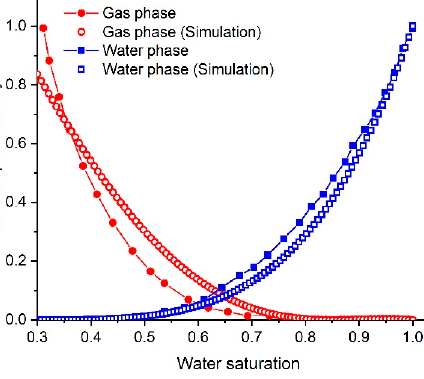
Figure 4. Relative permeability curve for history matching and simulation project. Table 1. Parameters of the numerical simulations.